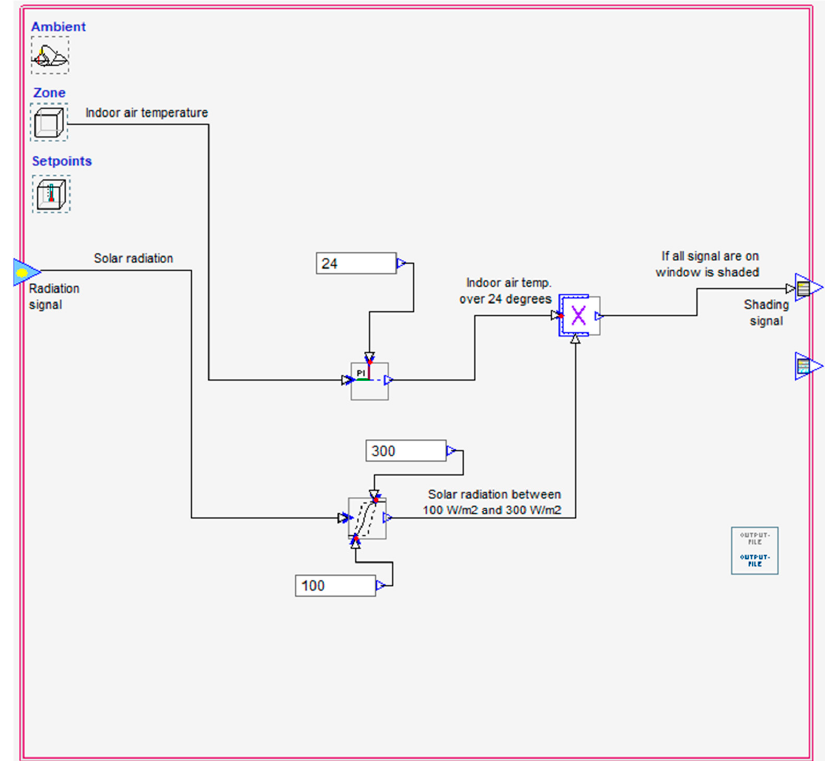
Energies 2022 , 15 , x FOR PEER REVIEW Figure A2. Control macro used for EC windows in design 4. Figure A2. Control macro used for EC windows in design 4.